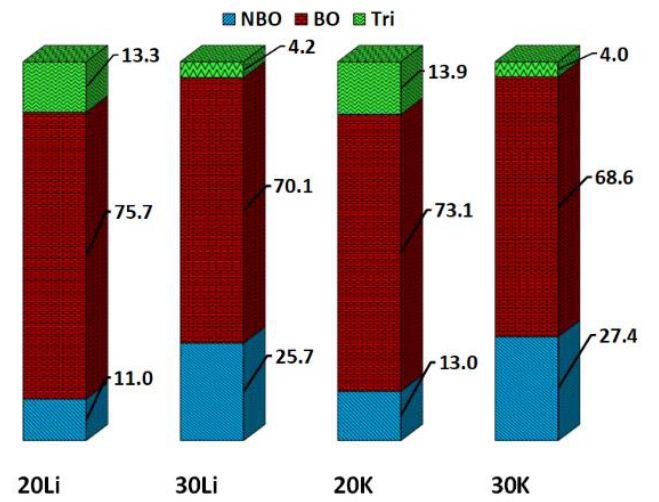
Table 4. Separation of NM-O coordination numbers (CN) into non-bridging oxygen (NBO), bridging oxygen (BO), and tri-cluster oxygen ions (Tri) and their fractions.